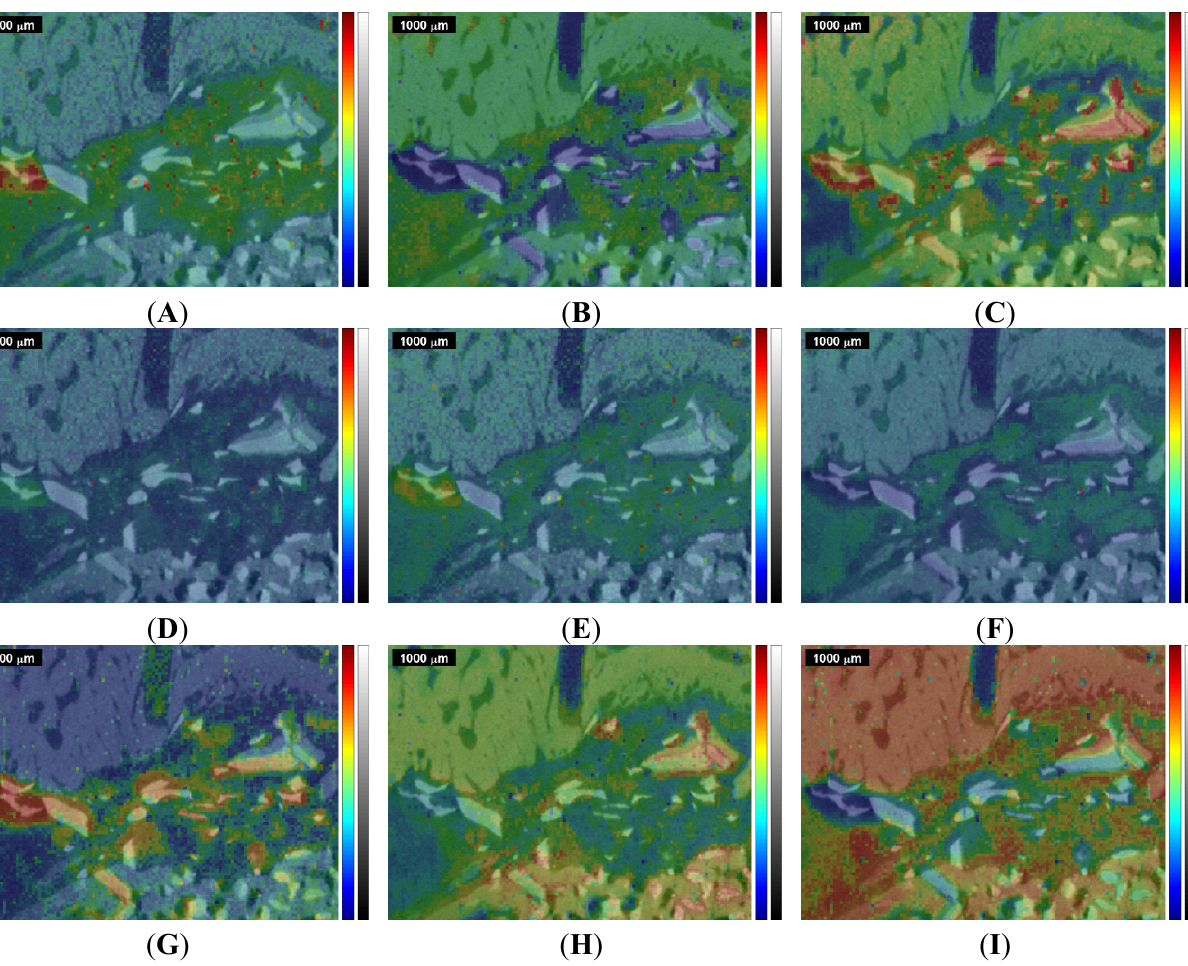
Figure 4. Overlap of the µ-CT image with the Raman images and correlation maps obtained within ROI 1 from the 1st measurement of the sinus grafted bone sample (compare Figure 2 and Supplementary Materials). Upper row: ( A ) Raman image centered at the CH bending peak at 1457 cm − 1 ; ( B ) natural pork fat Raman correlation map; ( C ) Raman image centered at the ν 1 PO 43 − peak at 961 cm − 1 . Mid row: Raman images centered at ( D ) the B-type carbonate substitution peak at 1075 cm − 1 ; ( E ) the amide I peak at 1677 cm − 1 ; ( F ) the CH stretching peak at 2937 cm − 1 . Lower row: correlation of the individual spectra of the Raman map with the ( G ) Bio-Oss ® Raman spectrum; ( H ) natural pork bone Raman spectrum; ( I ) tricalcium phosphate Raman spectrum.